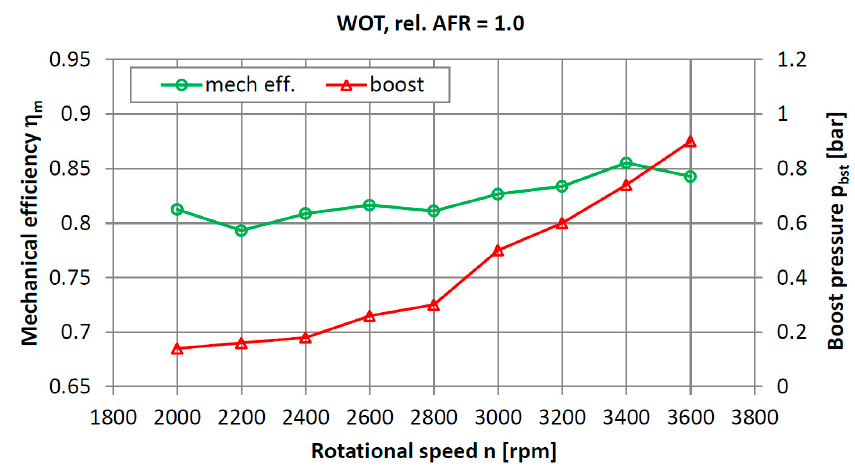
Figure 15. Mechanical efficiency and boost pressure as a function of the rotational speed at WOT.